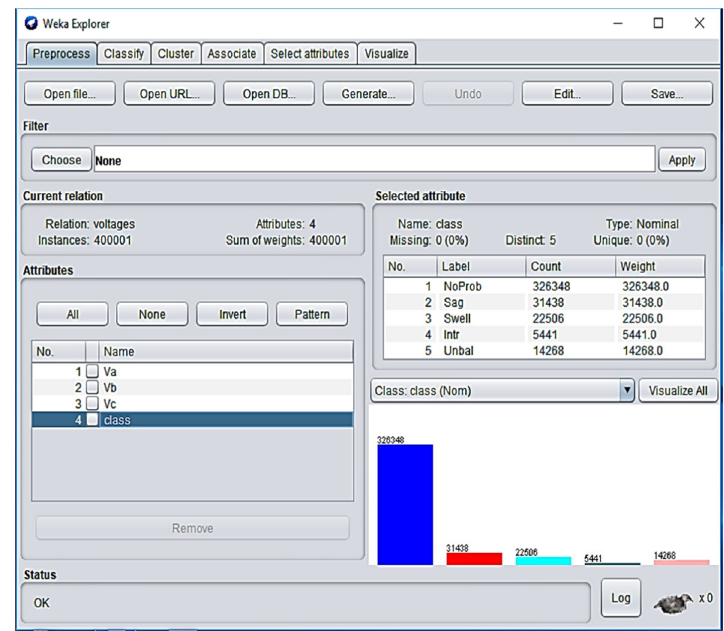
Fig. 9 Pre-process stage of data mining in WEKA with 4